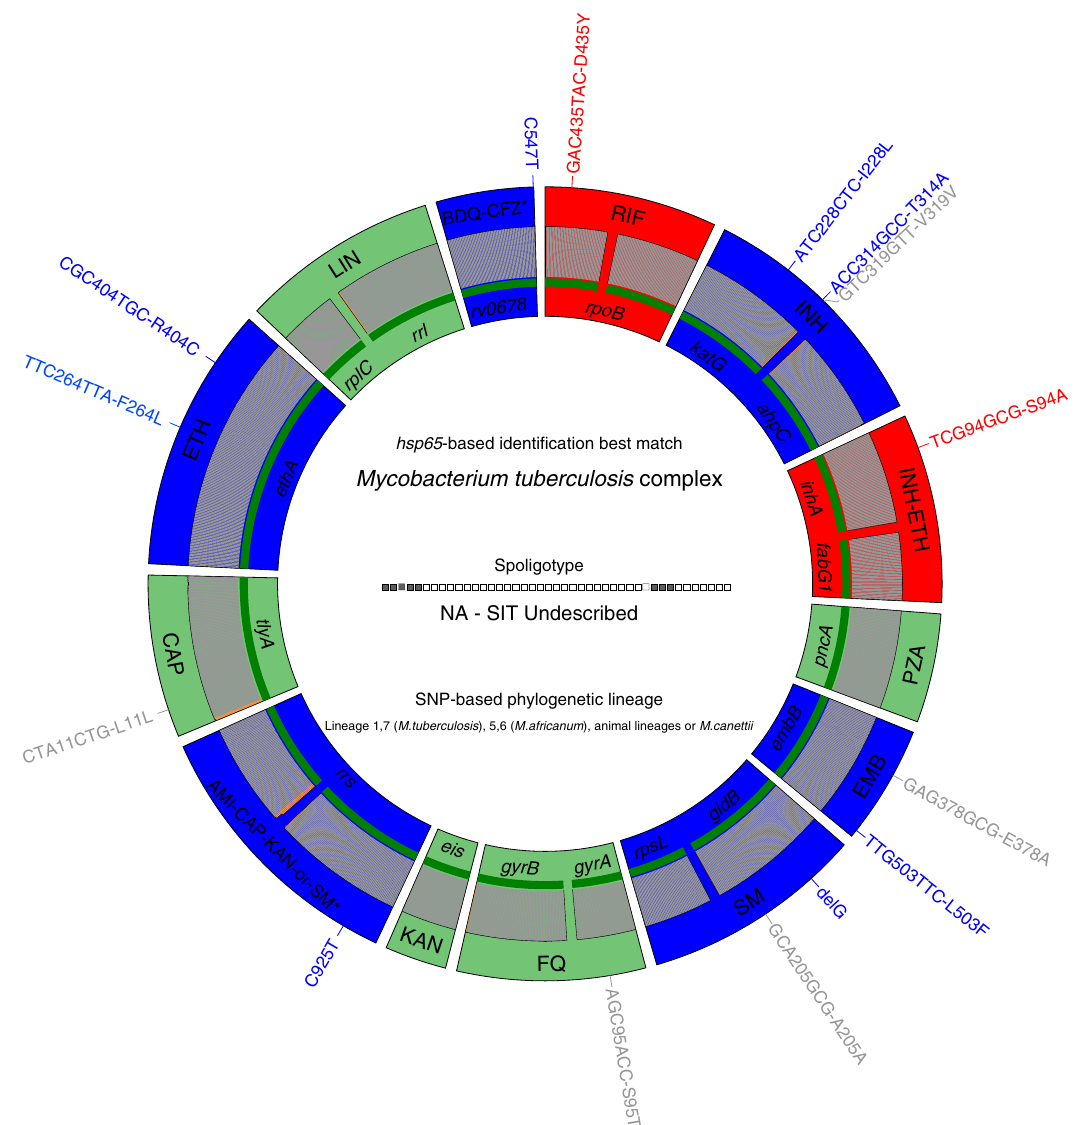
Fig. 2 Deeplex-MycTB results identifying a MDR-TB strain from Rwanda with an atypical genotypic pro fi le. Deeplex-MycTB results identifying a MDR- TB strain from Rwanda with an atypical genotypic pro fi le. Target gene regions are grouped within sectors in a circular map according to the tuberculous drug resistance with which they are associated. The two sectors in red indicate regions where rifampicin and isoniazid resistance-associated mutations are detected. The multiple sectors in blue refer to regions, where as yet uncharacterised mutations are detected, whereas sectors in green indicate regions where no mutation or only mutations not associated with resistance (shown in grey around the map) were detected. Green lines above gene names represent the reference sequences with coverage breadth above 95%. Limits of detection (LOD) of potential heteroresistance (re fl ected by subpopulations of reads bearing a mutation), depending on the coverage depths over target sequence positions, are represented by grey (LOD 3%) and orange zones (variable LOD > 3 – 80%; only seen in extremities of a few targets, such as the two rrs regions) above the reference sequences within the sectors. Information on an unrecognised spoligotype, an equivocal SNP-based phylogenetic lineage and on mycobacterial species identi fi cation, based on hsp65 sequence best match, are shown in the centre of the circle. AMI amikacin, BDQ bedaquiline, CAP capreomycin, CFZ clofazimine, EMB ethambutol, ETH ethionamide, FQ fl uoroquinolones, KAN kanamycin, LIN linezolid, INH isoniazid, PZA pyrazinamide, RIF rifampin, SM streptomycin, SIT spoligotype international